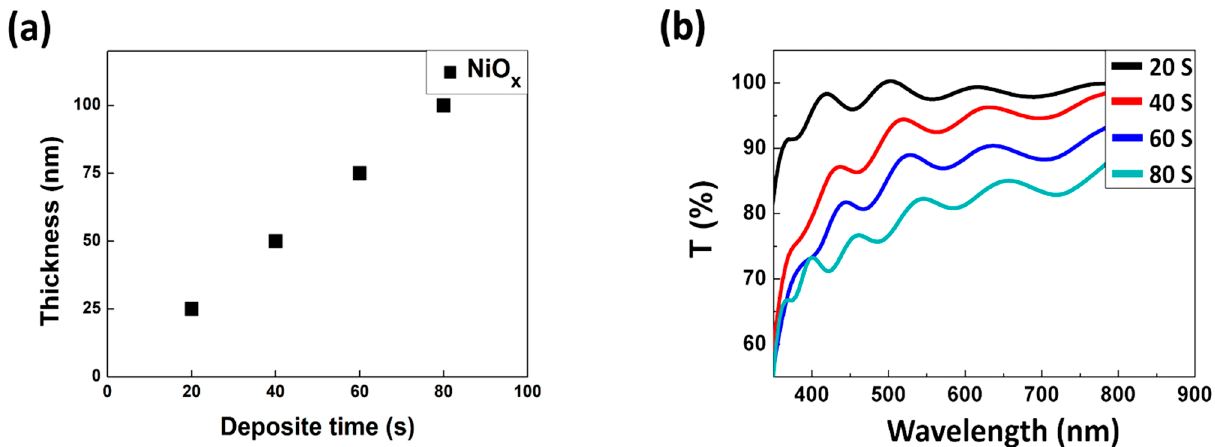
Figure 2. NiO x films prepared to various deposit times: ( a ) from deposit times: 20 s, 40 s, 60 s, and 80 s, respectively, were annealed at 500 °C for 1 h. The equivalent thicknesses are 25 nm, 50 nm, 75 nm, and 100 nm, respectively; ( b ) transmittance vs. wavelength (350–900 nm) for various NiO x thin films.